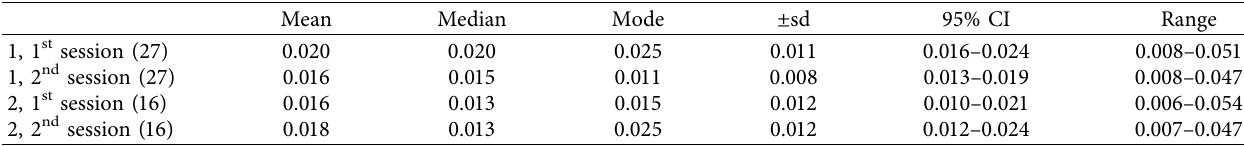
Table 3: Intersessional differences in Ko estimations. 1 � Ko values estimated by operator 1. 2 � Ko estimated by operator 2. Figures in parentheses are the number of individual cases in each